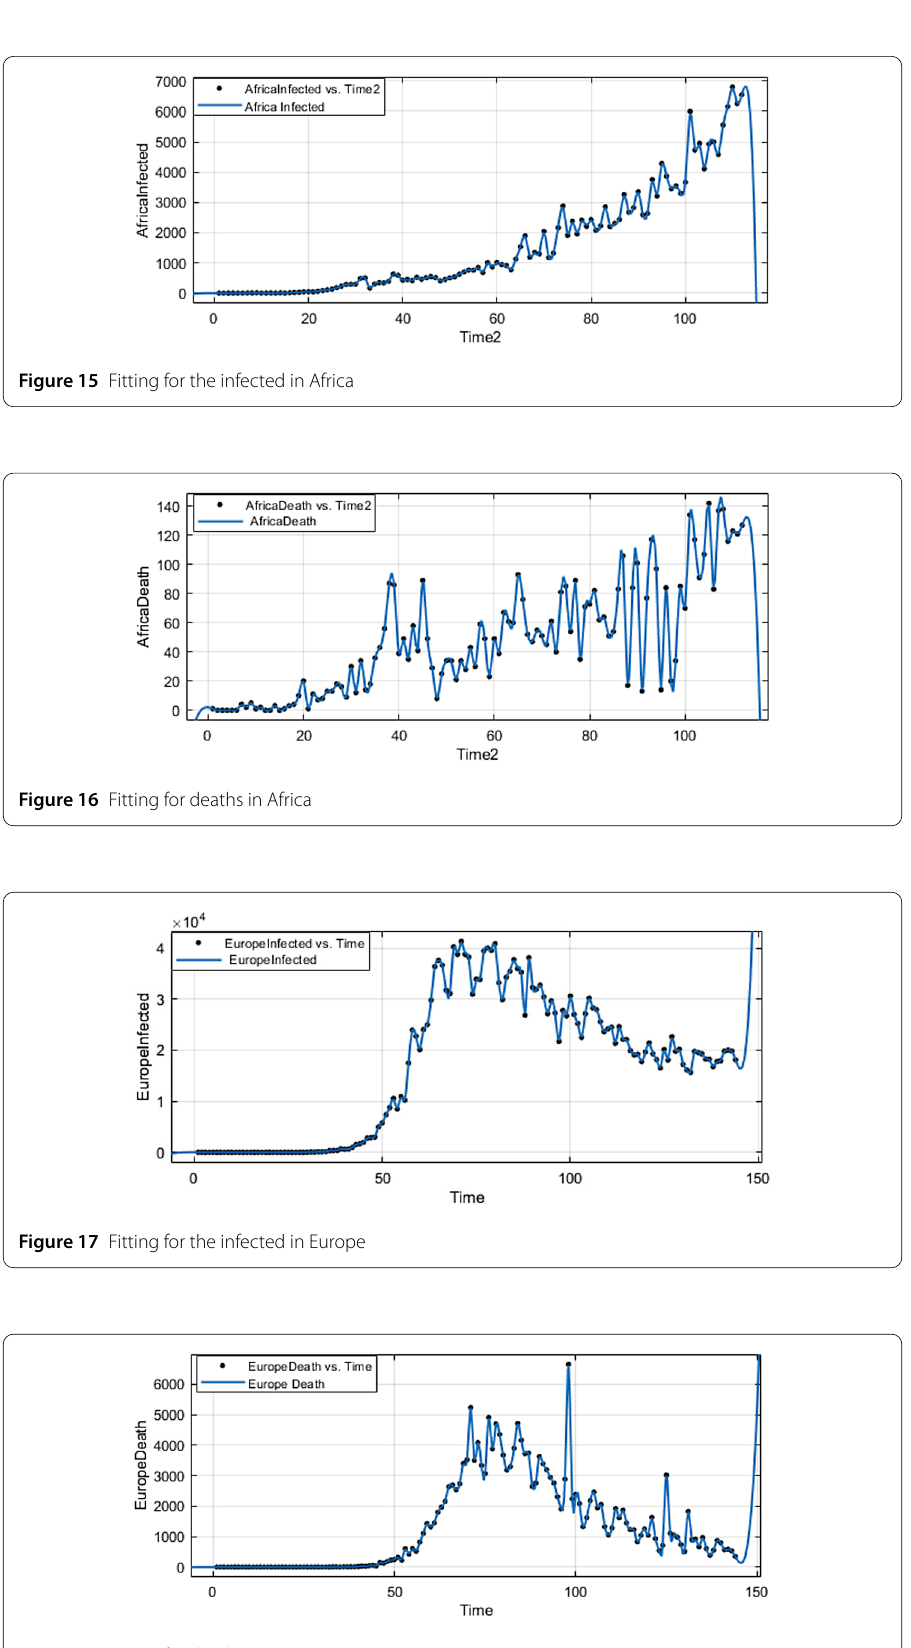
Figure 18 Fitting for deaths in